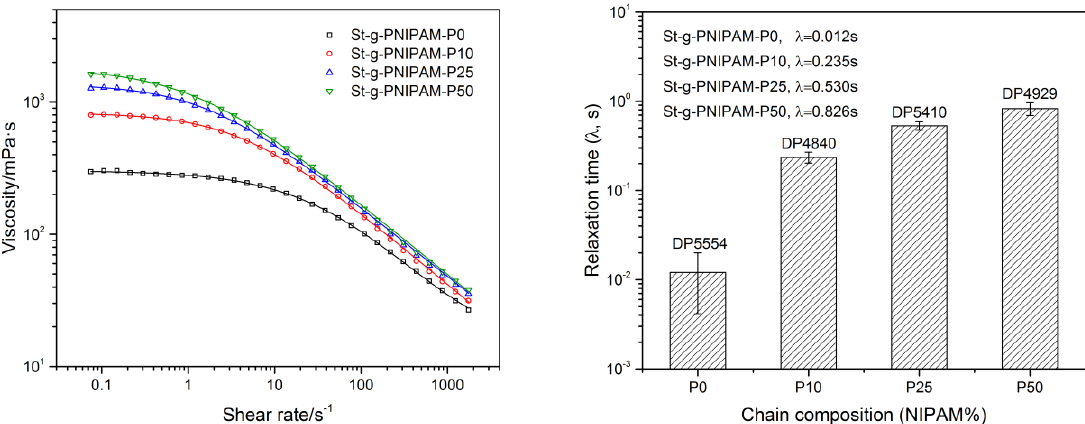
Figure 3. Viscosity as a function of shear rate ( Left , 1.2 wt % copolymer solution) and corresponding relaxation time from the “Carreau–Yasuda” model ( Right ).